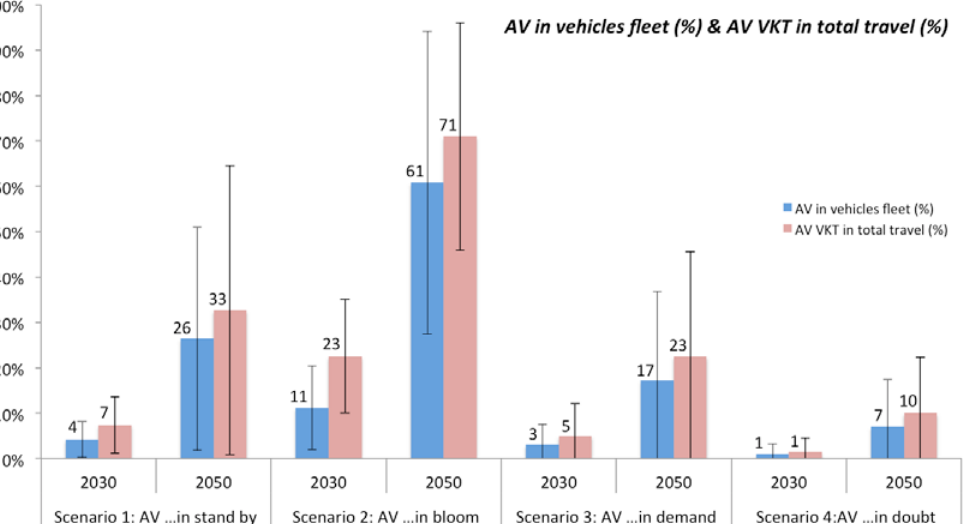
Figure 3. Estimation of (a) percentage of (conditionally and fully) automated vehicles in vehicles’ fleet and (b) percentage of VKT by (conditionally and fully) automated vehicles in total VKT, in 2030 and 2050. Each bar represents average value of five experts responses collected in Delft University of Technology workshops and error bar depicts standard deviation.